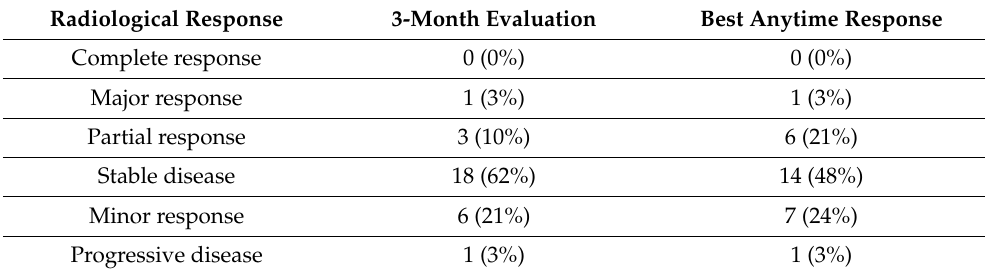
Table 2. Objective radiological responses according to RAPNO criteria at 3-month MRI and best anytime response during the treatment period, expressed as number of patients and